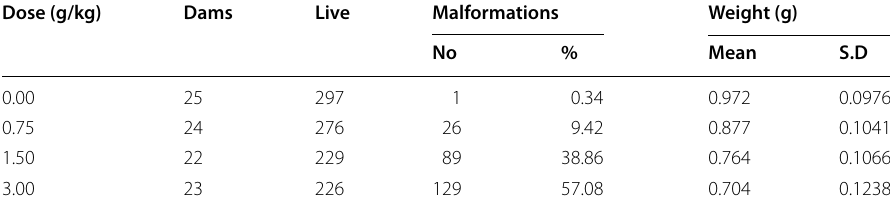
Table 3 Descriptive Statistics for crack growth data Dose (g/kg) Dams Live Malformations Weight